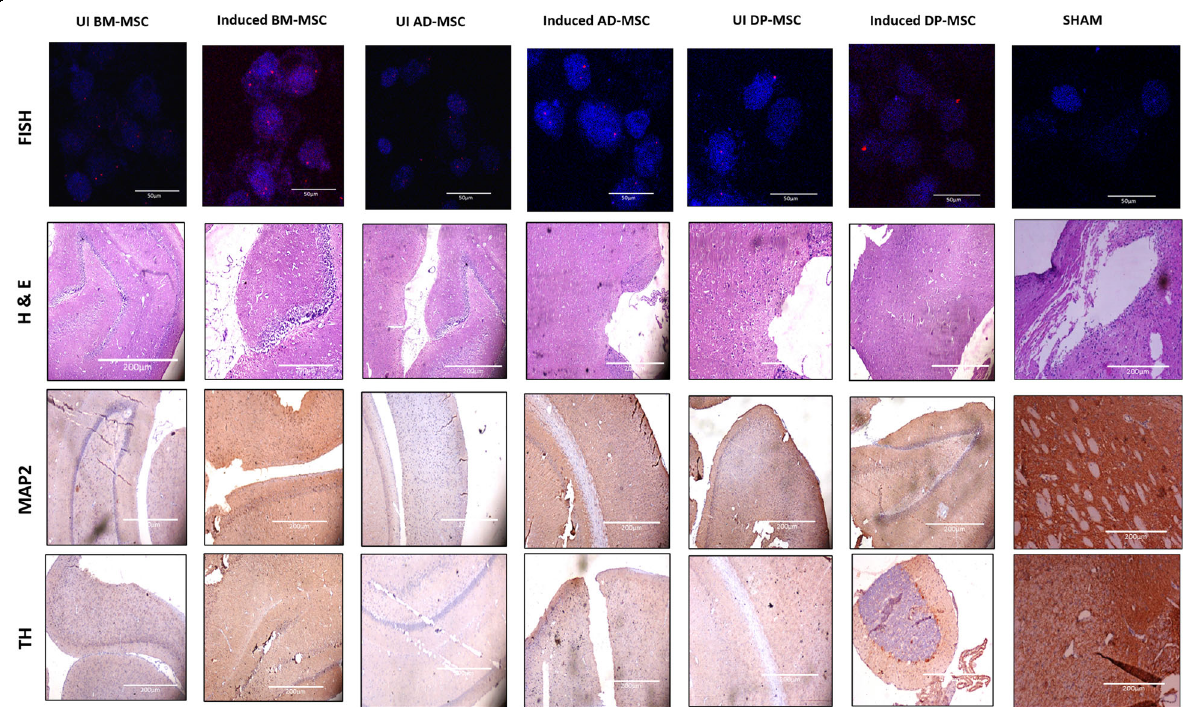
Fig. 8 Fluorescent in situ hybridization study. To investigate the homing of transplanted hMSCs in the SNpc region of Wistar rat brain (scale bar 50 µm); Hematoxylin and eosin staining to check the presence of any in fl ammatory cells in the SNpc region of Wistar rat brain (scale bar 50 µm); immuno-histochemical analysis to study the differential expression of MAP2 and TH proteins in the SNpc region of Wistar rat brain (scale bar 200 µm). All these analyses were performed subsequently in all the study